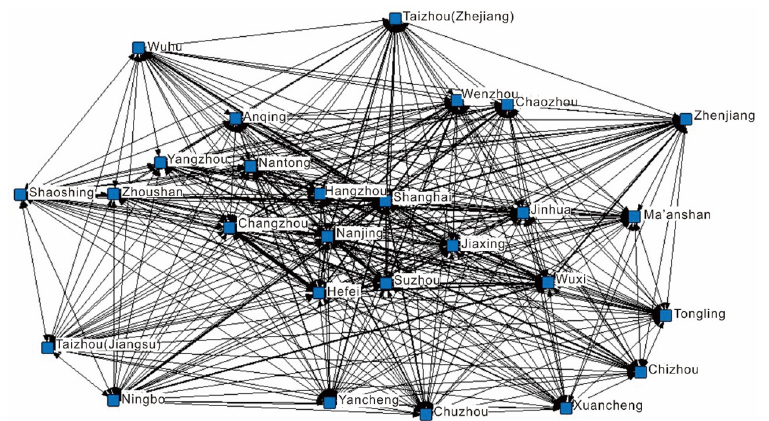
Fig 3. The demand network of regional tourism cooperation in the Yangtze River Delta.